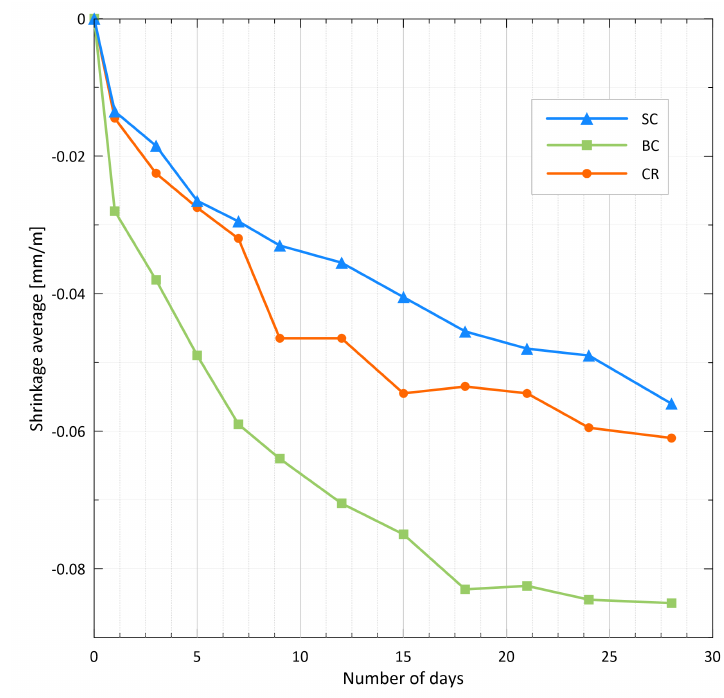
Figure 6. The measurement results of shrinkage.